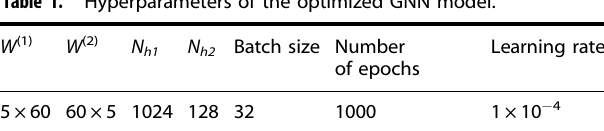
Table 1. Hyperparameters of the optimized GNN